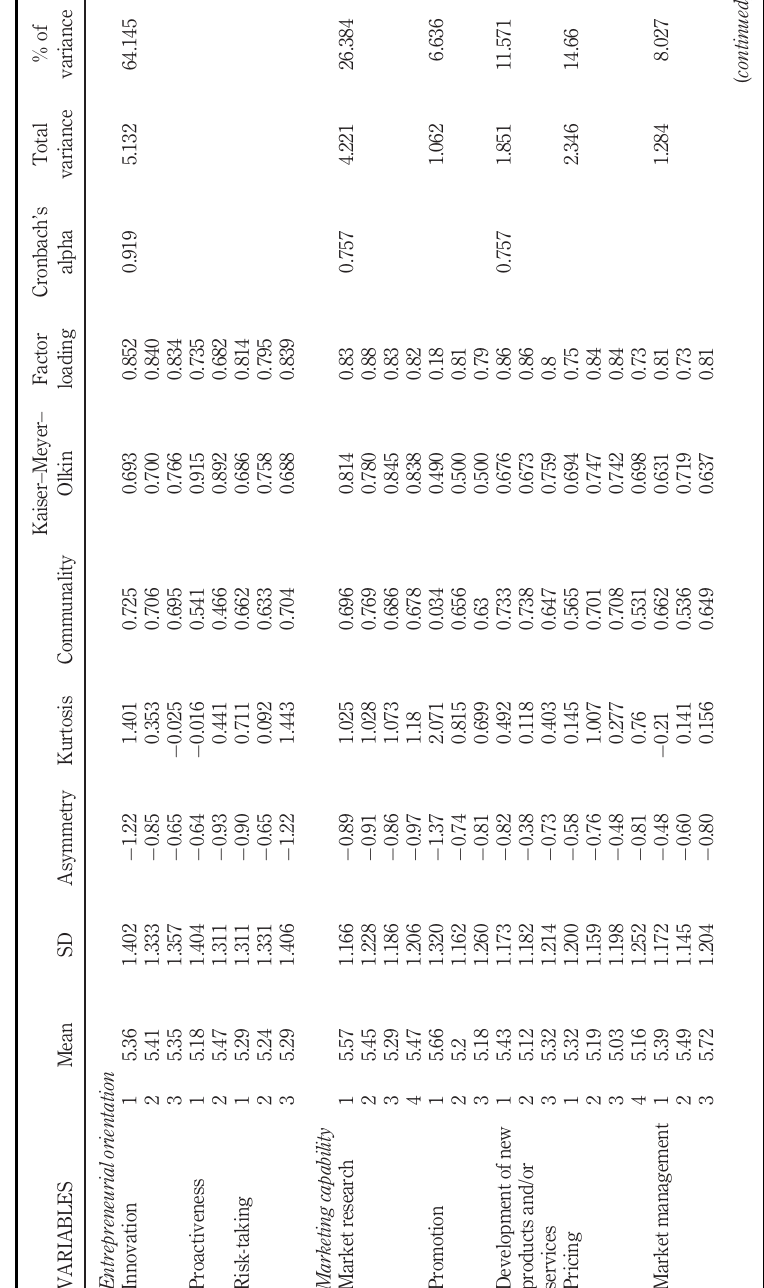
Table I. Results of analyses of constructs in data collected at EXPOSUPER